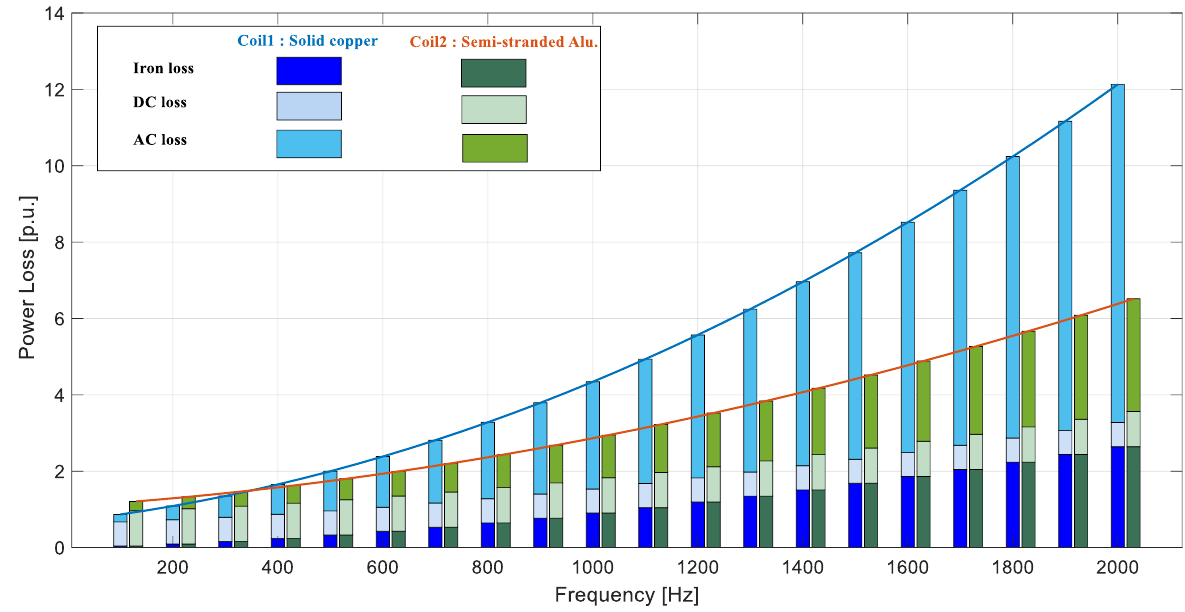
Figure 13. The measured losses at different frequency levels for the solid copper coil and the semi- stranded aluminum coil.